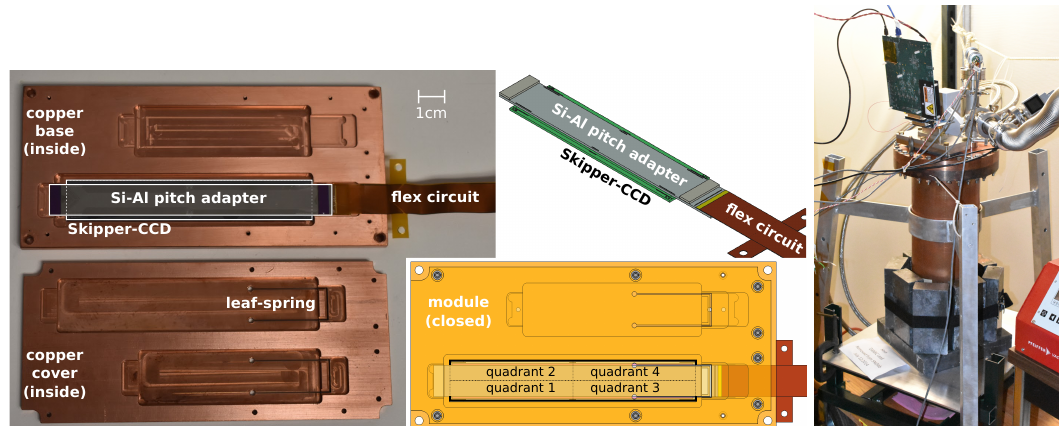
Figure 15: The CCD used in the 2020 SENSEI measurement was glued to a silicon- aluminum pitch adapter, which in turn was laminated with a copper-Kapton flex ca- ble; this CCD module was then placed in a copper tray (left). Figure from Ref. [ 74 ] 5 . The tray was installed in a vacuum vessel with a lead shield (right), underground in the MINOS cavern at Fermilab.